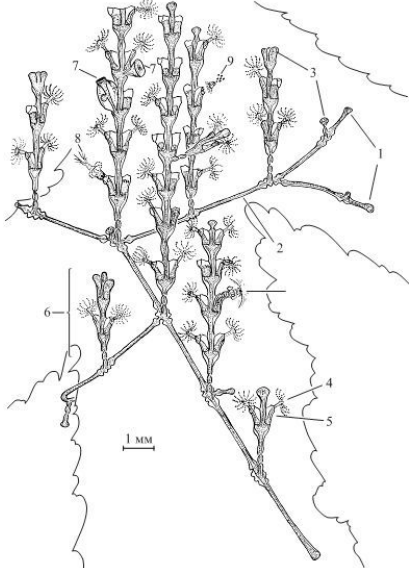
Figure 1. Colony of the hydroid Dynamena pumila (L.) Legend: 1—tips of the stolon growth; 2—stolons; 3—tips of the shoot growth; 4—hydrant with an open rim of tentacles; 5—hydrotheca; 6—young shoot; 7—gonangium (gonotheca with blastostyle inside); 8—hydrants swallowing the victim; 9—excretion of undigested food debris from the hydrant. Repeated (cyclic) morphogenesis [11] means that in the process of differentiation, in